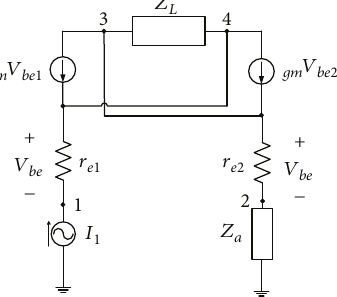
Figure 2: Simpli fi ed equivalent circuit of the fl oating NIC with a current source I 1 at port 1 and an impedance Z